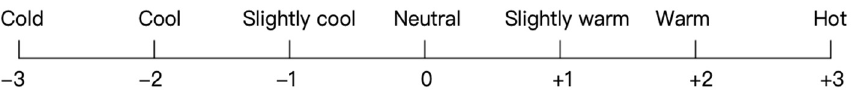
Figure 3. Thermal sensation 7-point scale of